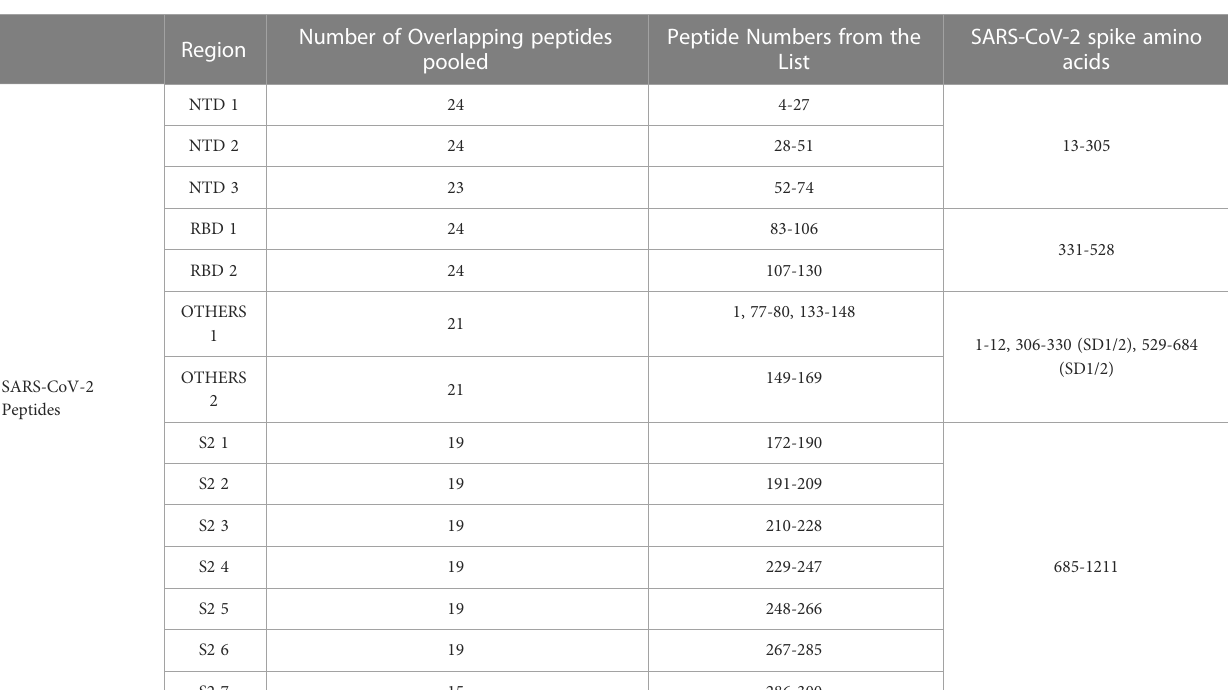
TABLE 2 Pooling arrangement SARS-CoV-2 spike peptides from JPT. Number of Overlapping peptides Region pooled